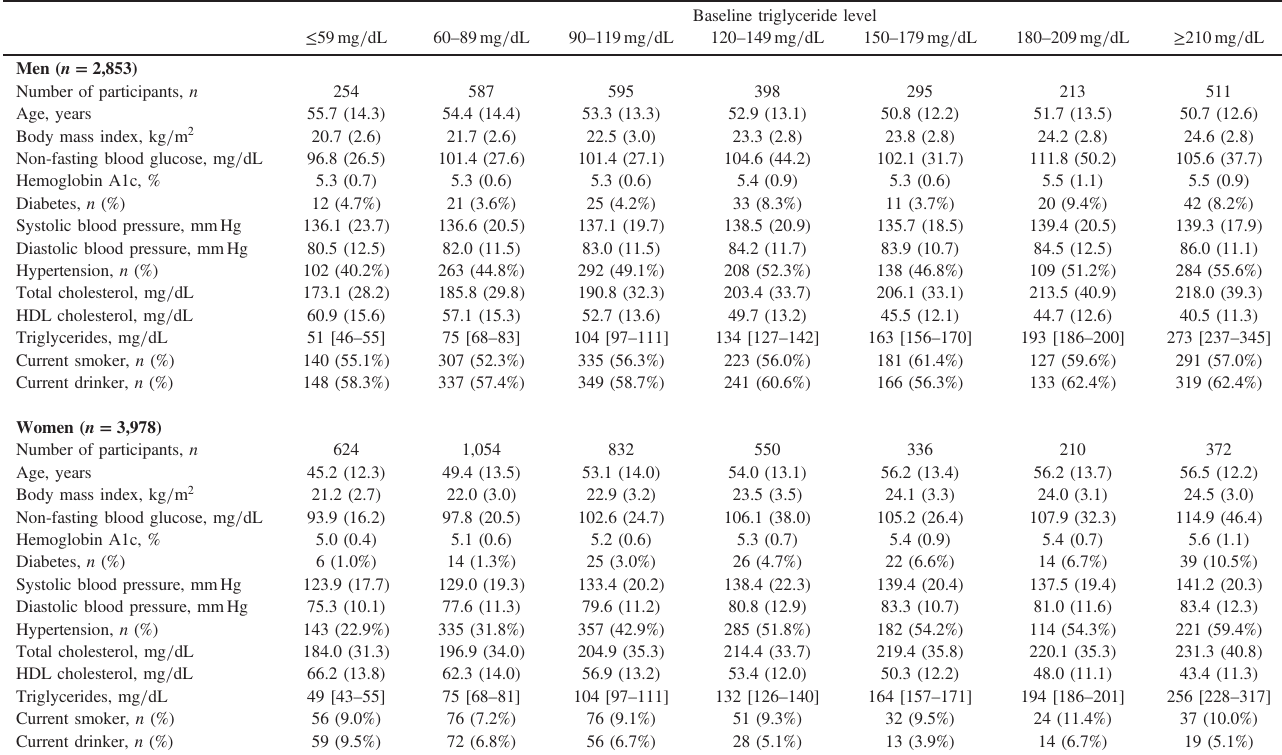
Table 1. Characteristics of study participants according to non-fasting triglyceride category by sex at the baseline